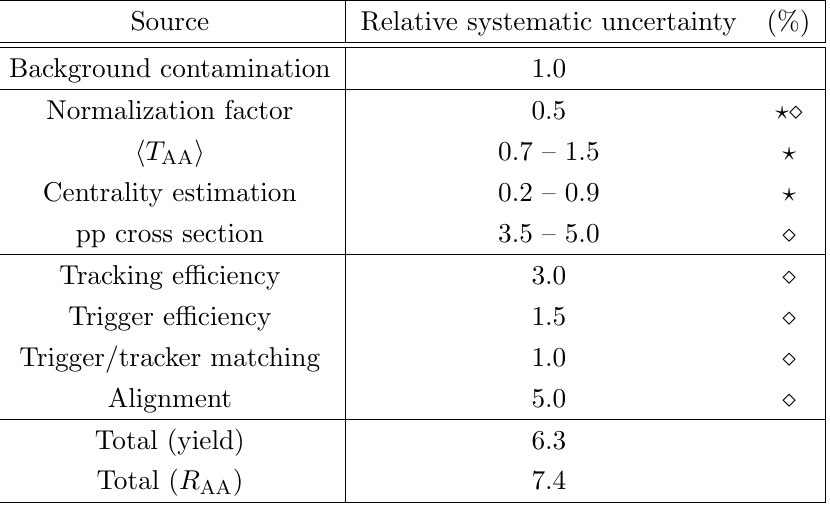
Table 2 . Components of the relative systematic uncertainties on the Z-boson yield and R AA in the Pb-Pb analysis. See text for details. The ? symbol indicates a rapidity-dependent correlated uncertainty, while the uncertainty sources correlated as a function of centrality are marked by a (cid:5) . In the total lines are reported the cumulative systematic uncertainty of the result integrated in centrality and